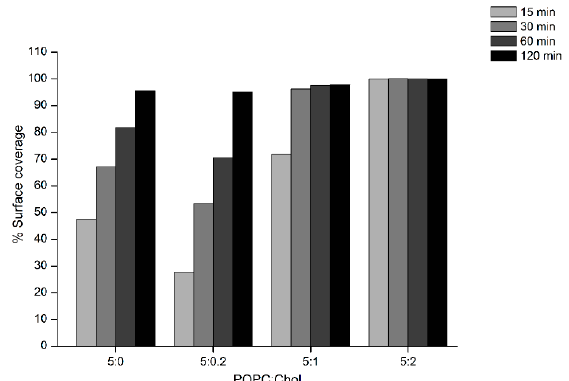
Figure 6. Analysis of AFM topographic image of Cyt2Aa2 protein binding on lipid bilayers. The surface coverage of protein binding as a function of time for different lipid/Chol bilayers was analyzed from set of image of Figure 5 (5 µm × 5 µm). The increasing of % surface coverage refers to the quantitative lipid binding. The AFM images were analyzed with bearing analysis of the NanoScope analysis program.